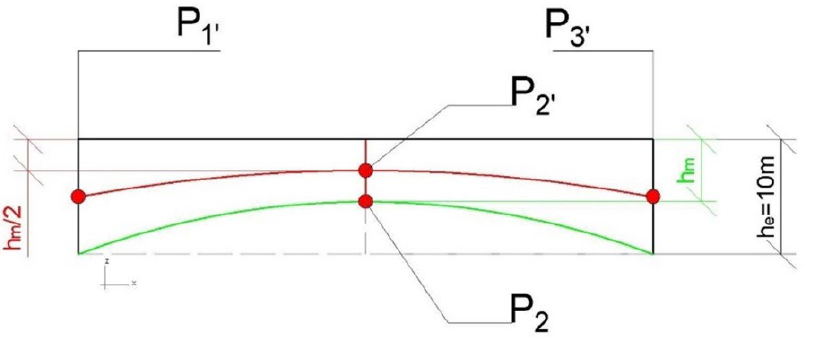
Figure 5. Shifted curve (Equation (8)).